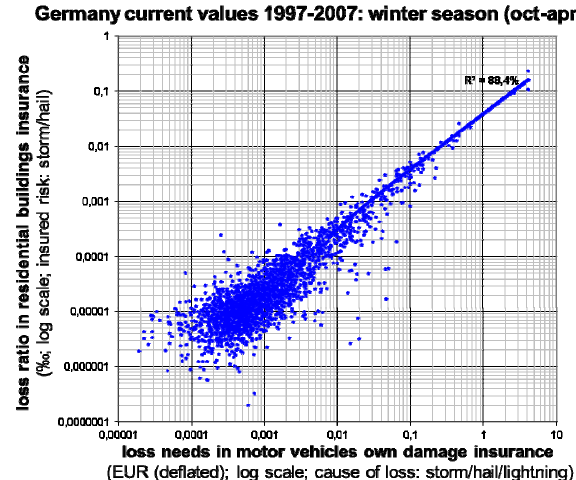
Figure 1: Regression of loss needs in motor vehicle insurance and losses to residential 4 Fig. 1. Regression of loss needs in motor vehicle insurance and buildings caused by natural hazards during the extended winter season October-April 5 losses to residential buildings caused by natural hazards during the (y=0.040 * x). The dots represent country-wide daily loss values. 6 extended winter season October–April (y=0.040 · x). The dots rep- resent country-wide daily loss